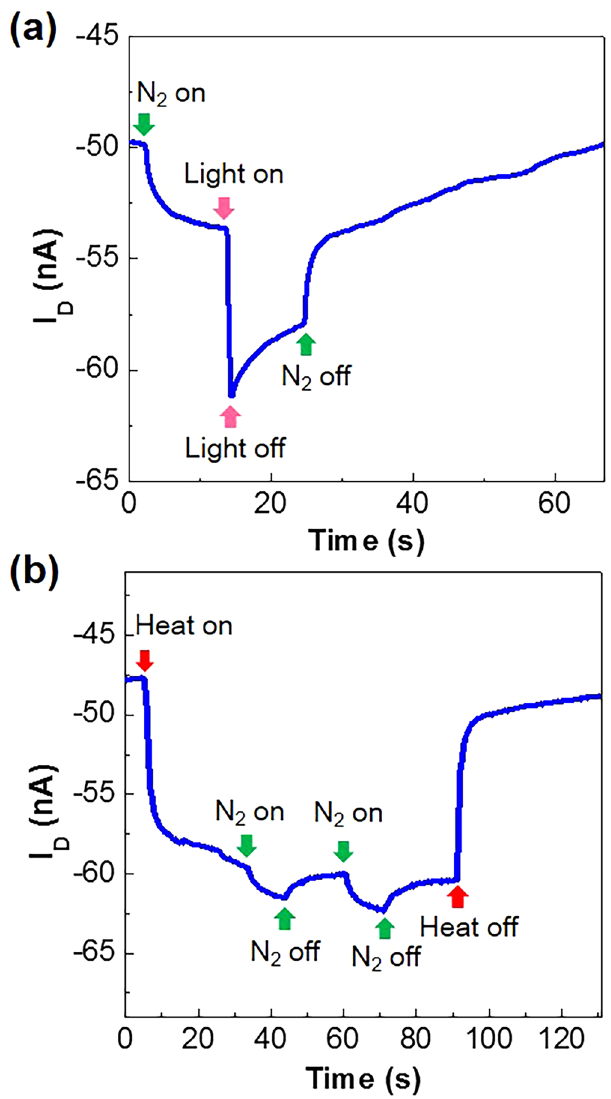
stimulations with heat (70 °C) and nitrogen gas flow (5 sccm). Note that applying sequences are different between ( a ) and ( b